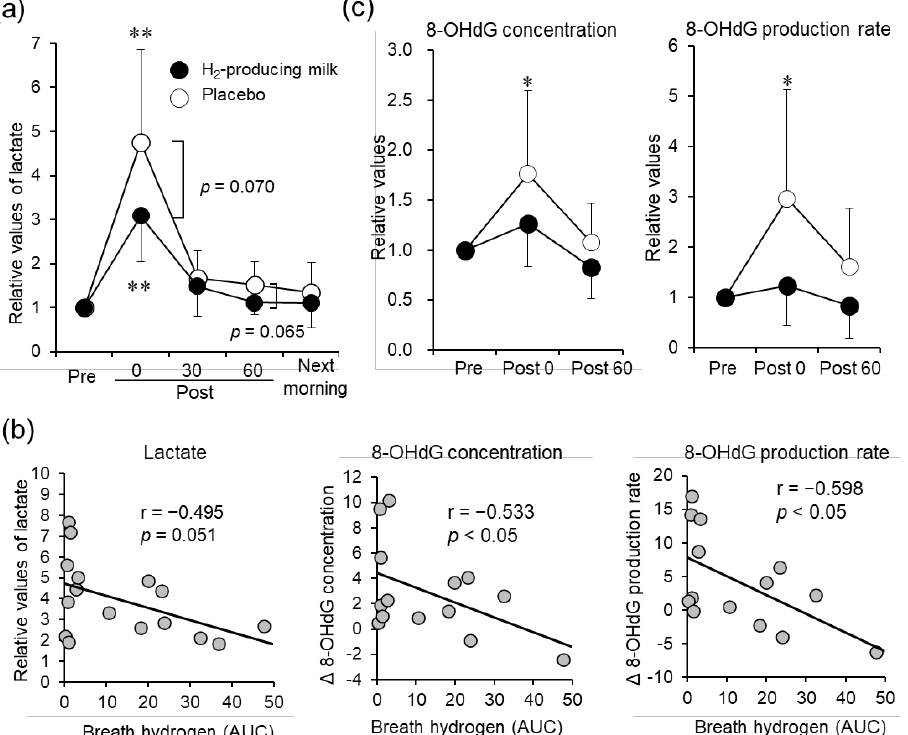
Figure 2. Effects of H 2 -producing milk and placebo use on blood lactate and 8-OHdG levels. ( a ) Time course of the relative lactate levels before and after exercise. ( b ) 8-OHdG concentration and production rate before and after exercise. The black and white plots represent the means during the H 2 -producing milk and placebo trials, respectively. Error bars represent the standard deviation of the mean. * p < 0.05, ** p < 0.01 (vs. before exercise; two-way repeated measures analysis of variance and Dunnett’s multiple comparison test). ( c ) Correlation between blood lactate and 8-OHdG levels and the AUC of the breath (Pearson’s product -moment correlation coefficient). 8-OHdG, 8-hydroxy-2 ′ -deoxyguanosine; AUC, area under the curve.